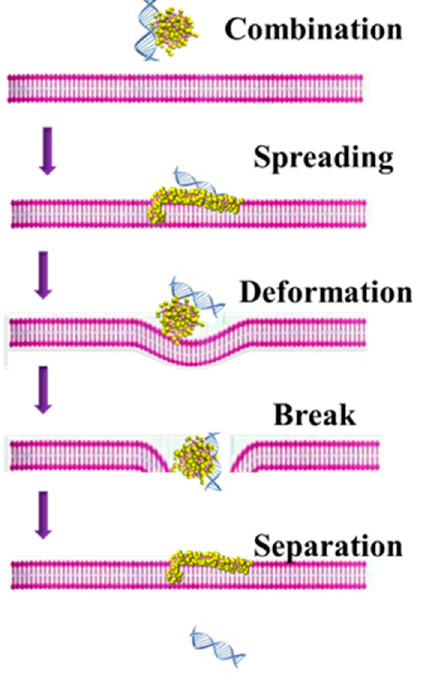
Figure 8. The possible mechanism of siRNA delivery assisted by PMAL.